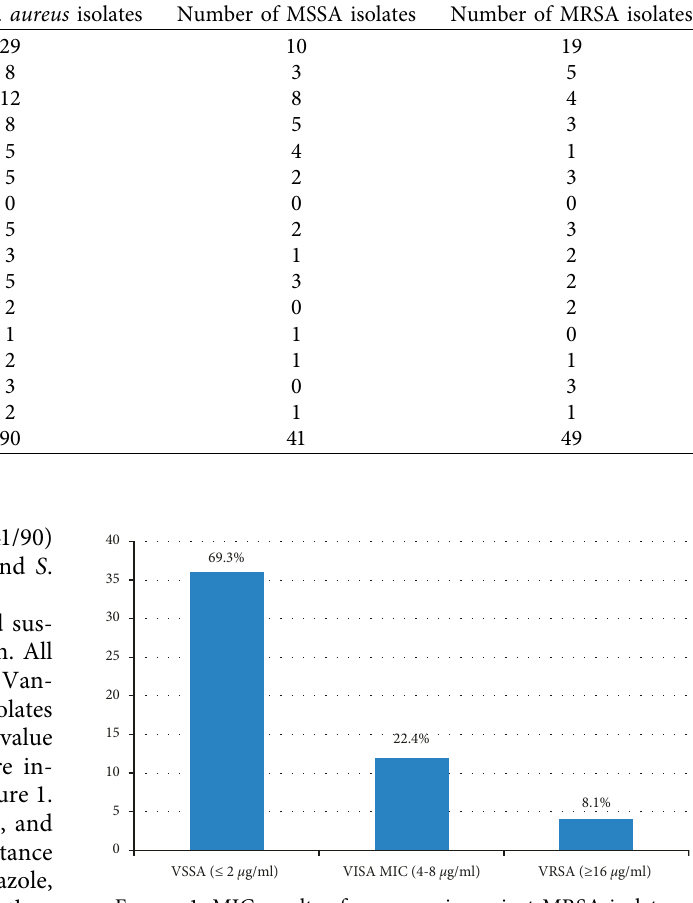
Table 2: Distribution of Staphylococcus aureus (MSSA and MRSA) isolated from environmental samples of intensive care units. Sampling sites